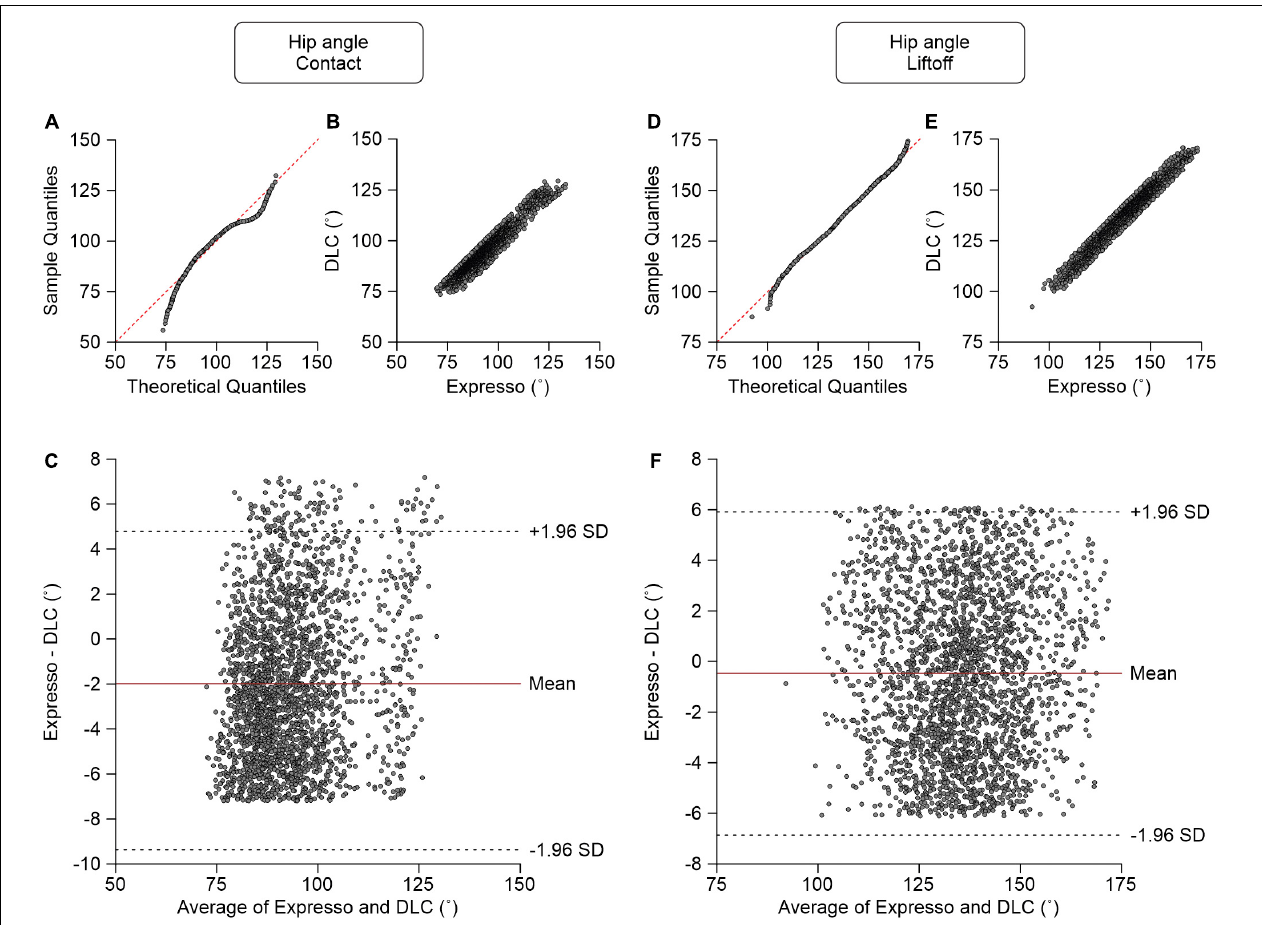
FIGURE 5 | Comparison of hip joint angles at contact and at liftoff measured with data from Expresso and DLC. (A) Hip angle at contact QQ-plot where the red dashed line represents a perfect normal distribution. (B) Hip angle at contact scatter plot of values obtained with Expresso and DLC. (C) Bland–Altman plot of hip angle at contact measurements from Expresso and DLC. The solid red line is the mean difference between the two methods and black dashed lines show ± 1.96 standard deviations. (D) Hip angle at liftoff QQ-plot where the red dashed line represents a perfect normal distribution. (E) Hip angle at liftoff scatter plot of values obtained with Expresso and DLC. (F) Bland–Altman plot of hip angle at liftoff measurements from Expresso and DLC. The solid red line is the mean difference between two methods and black dashed lines show ± 1.96 standard